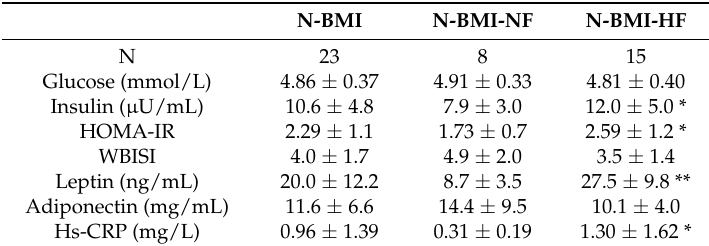
Table 2. Metabolic risk indicators (mean ± SD).